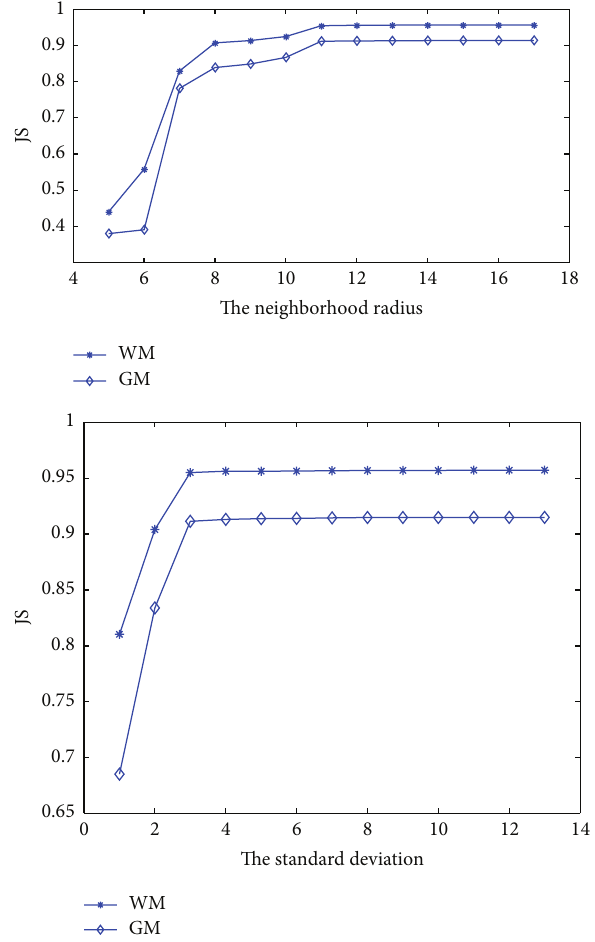
Figure7:TheJSvaluesofthesegmentationresultsobtainedbyusing the different parameters setting of the truncated Gaussian kernel.